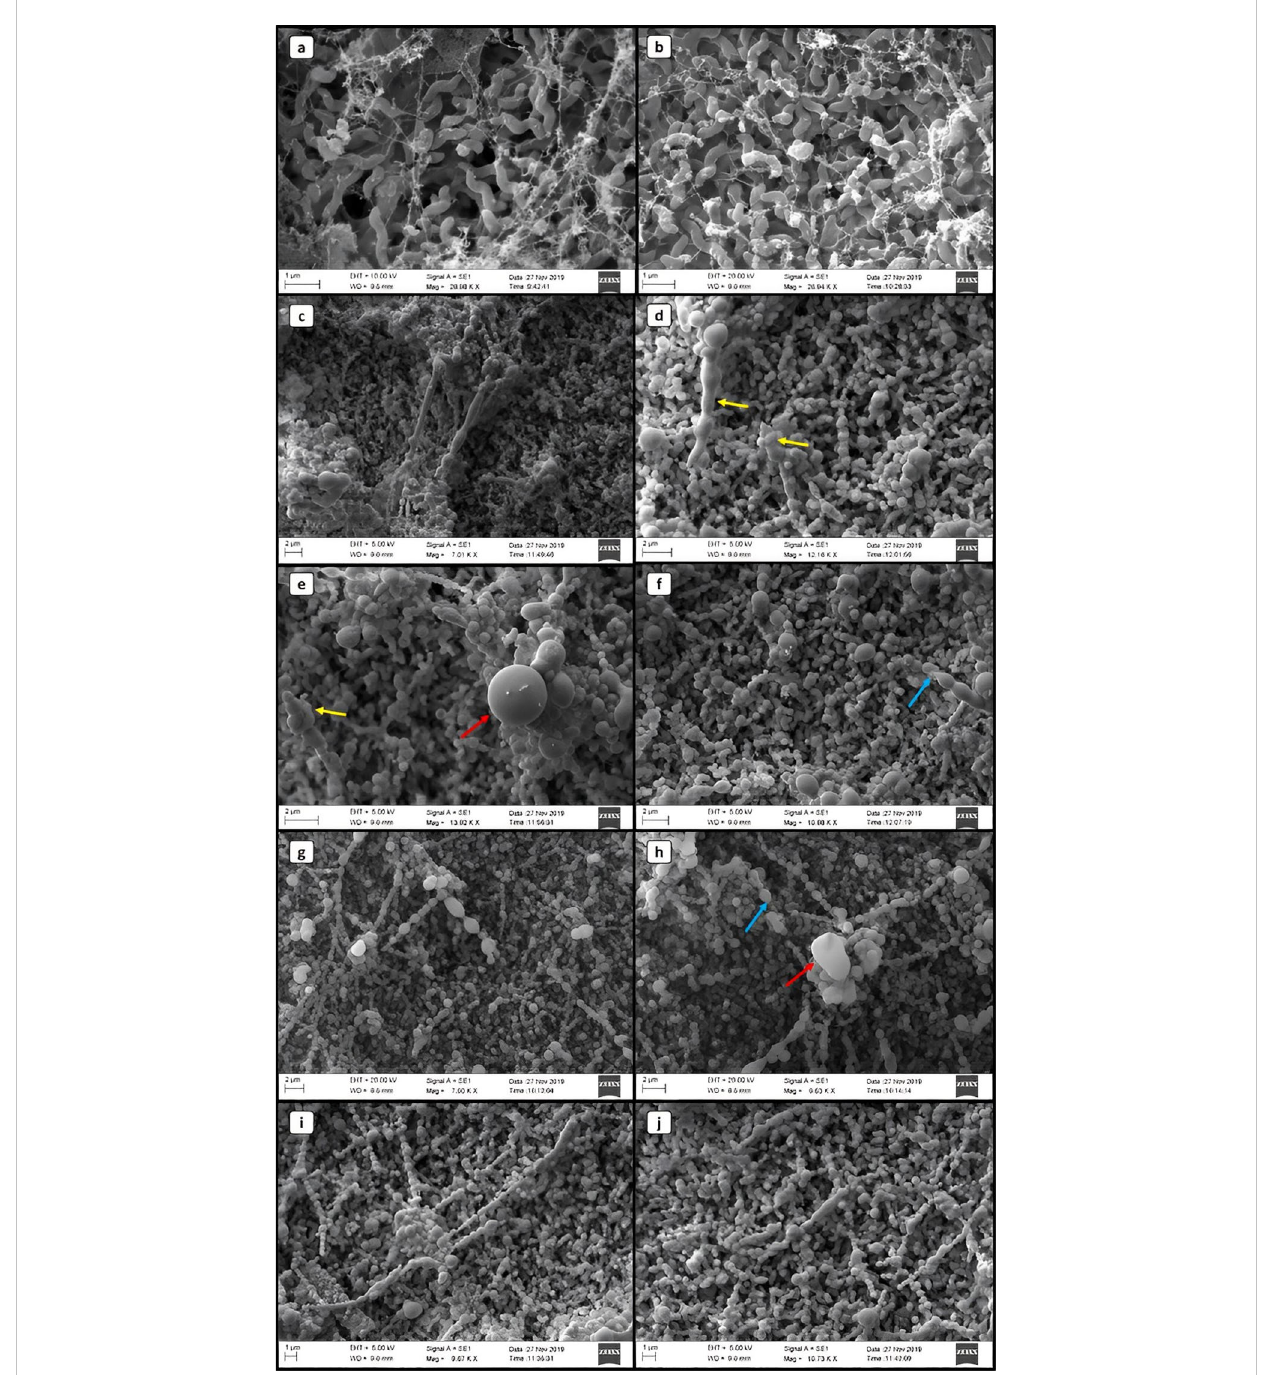
FIGURE 2 Scanning electron microscopy images of Campylobacter jejuni in different life forms. (A, B) VT. (C – J) CNV. Yellow arrows indicate changes in the cell wall. Red arrows highlight cocci with a diameter of approximately 2 m m. Blue arrows indicate the possible basal structure of the fl